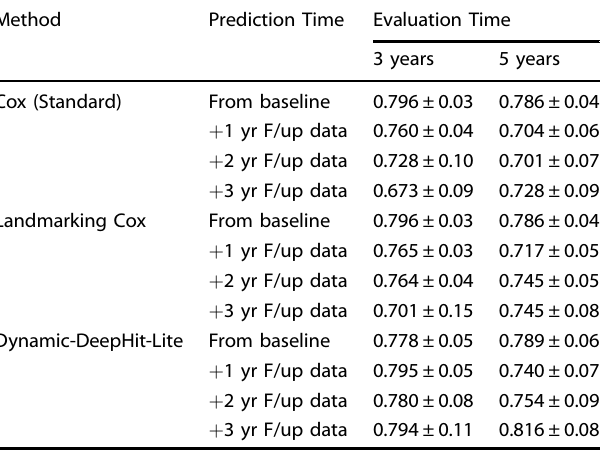
Fig. 2 Illustration of the Dynamic-DeepHit-Lite (DDHL) survival analysis data collection method and its use in prediction modelling. CPG 3 (Cambridge Prognostic Group 3) event as the endpoint. Table 2. Model discrimination performance for prediction of progression to Cambridge Prognostic Group 3 (CPG3)